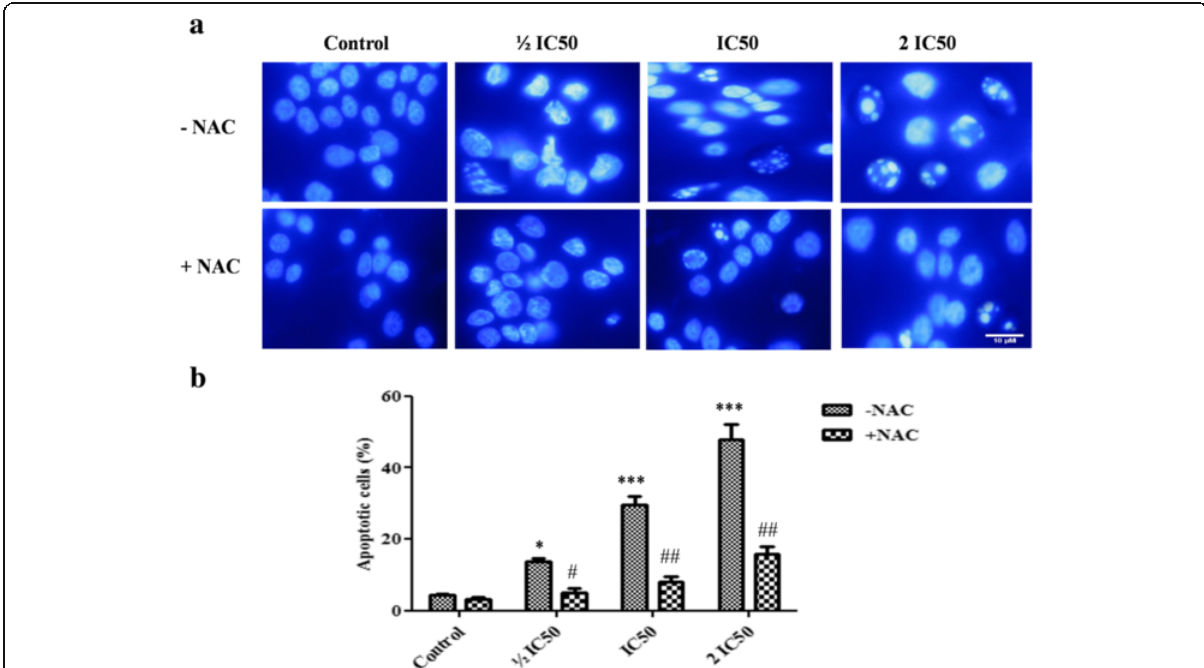
Fig. 4 Apoptosis induced by F3 fraction. a Apoptotic morphology changes of NCI-H358 lung cells 24 h after F3 fraction treatment (½ IC 50 , IC 50 and 2 IC 50 ) in the absence ( – NAC) or presence (+NAC) of N-acetylcysteine. Cells were stained with Hoechst 33258 and visualized by fluorescence microscopy (Zeiss Axioplan, Germany; magnification 400×). b Percentage of apoptotic cells induced by F3 fraction with or without NAC pre-treatment